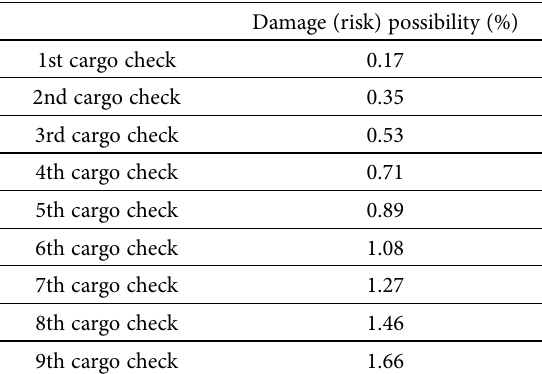
Table 5. Cargo damage possibilities Damage (risk) possibility (%)